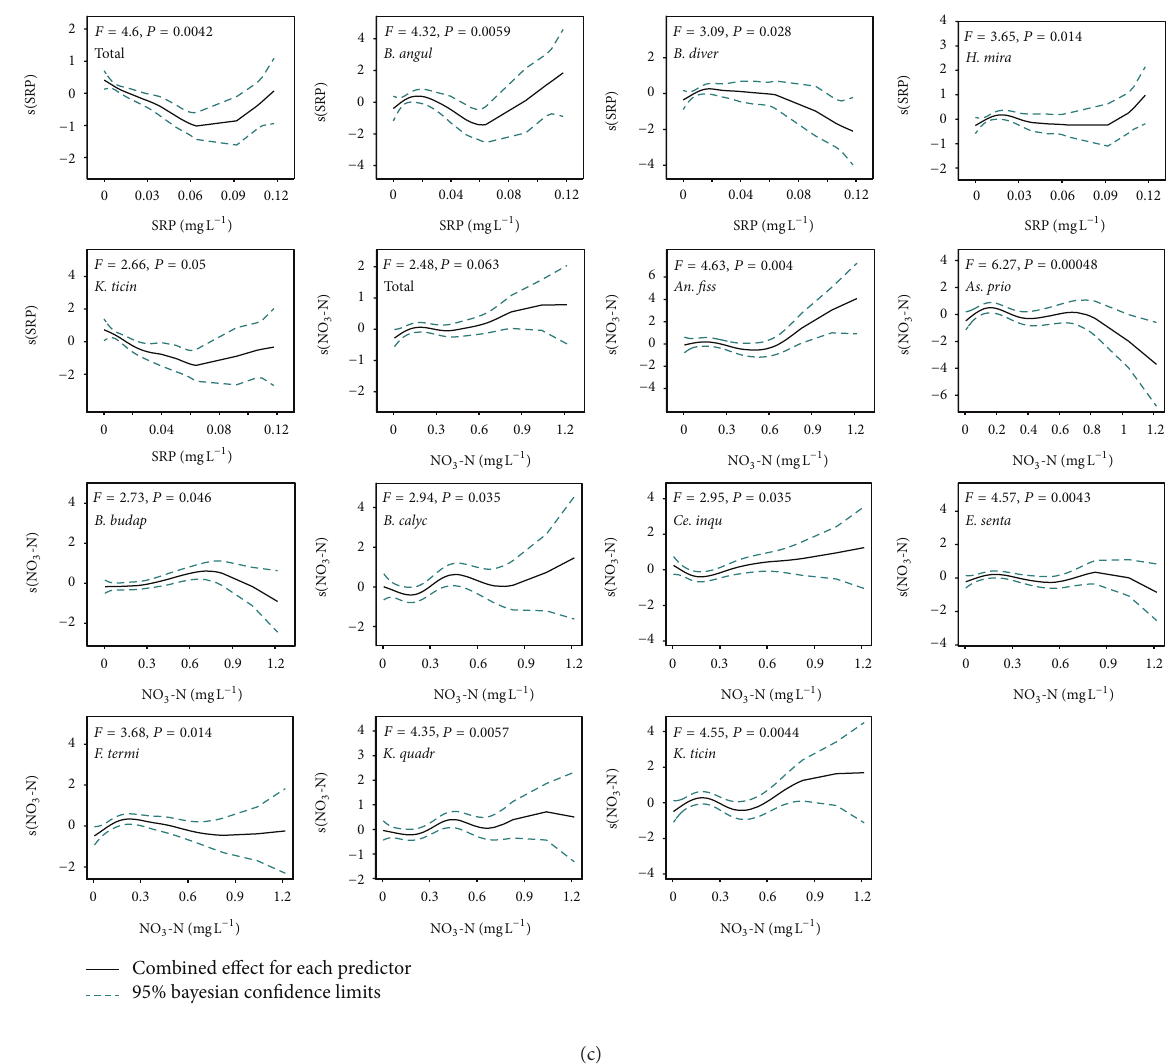
Figure 6: Plots showing the effect of selected environmental parameters on rotifer densities. For the total rotifer density, all of the selected parameters are shown. For the individual species densities, only the selected parameters with significance ( 𝑃 < 0.05 ) are shown: ( 𝑛 = 169 ).